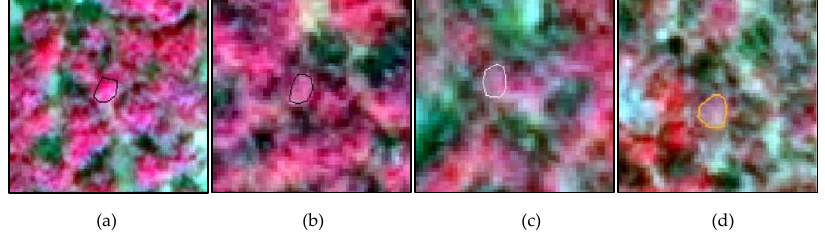
Figure 3. Example of delineated tree damage (levels 1–4) using WV-3 pan-sharpened multispectral image (R: NIR 1; G: Red; B: Green). (a) Healthy tree. (b) Slightly infested tree. (c) Moderately infested tree. (d) Severely infested tree.